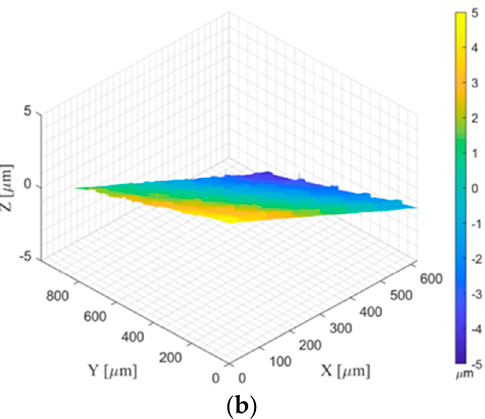
Figure 2. Surface reconstruction by the raw measurement data: ( a ) two-dimensional (2D) contour and ( b ) three-dimensional (3D) surf.